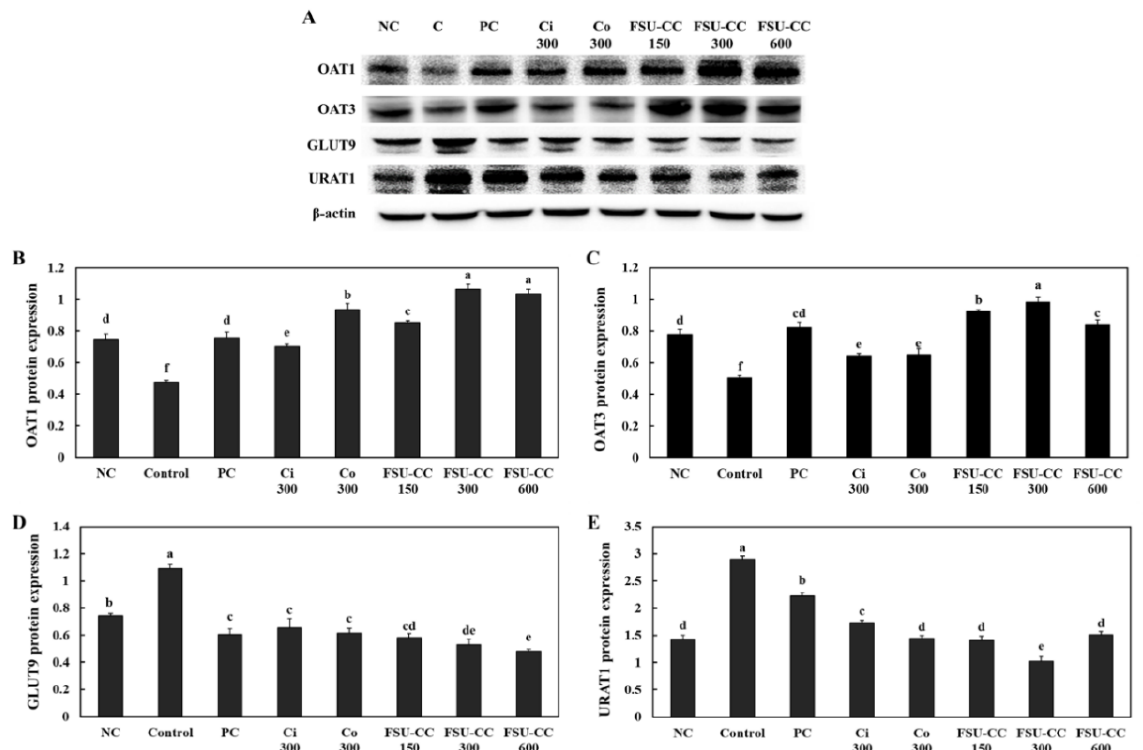
Figure 6. Expression levels of proteins by Western blotting (band images ( A ), relative protein expression ( B – E )) in the kidney of hyperuricemia-induced mice supplemented with and without Ci, Co, or FSU-CC. NC: normal control, C: hyperuricemia-induced mice, PC: hyperuricemia-induced mice with oral supplementation of allopurinol 10 mg/kg b.w., Ci 300: hyperuricemia-induced mice with oral supplementation of C. indicum L. 300 mg/kg b.w., Co 300: hyperuricemia-induced mice with oral supplementation of C. officinalis Siebold and Zucc. 300 mg/kg b.w., FSU-CC 150: hyperuricemia-induced mice with oral supplementation of mixture of C. indicum L. and C. officinalis Siebold and Zucc. (1:2) 150 mg/kg b.w., FSU-CC 300: hyperuricemia-induced mice with oral supplementation of mixture of C. indicum L. and C. officinalis Siebold and Zucc. (1:2) 300 mg/kg b.w., FSU-CC 600: hyperuricemia-induced mice with oral supplementation of mixture of C. indicum L. and C. officinalis Siebold and Zucc. (1:2) 600 mg/kg b.w. Different letters indicate significant difference at p < 0.05, as determined by Duncan’s multiple range